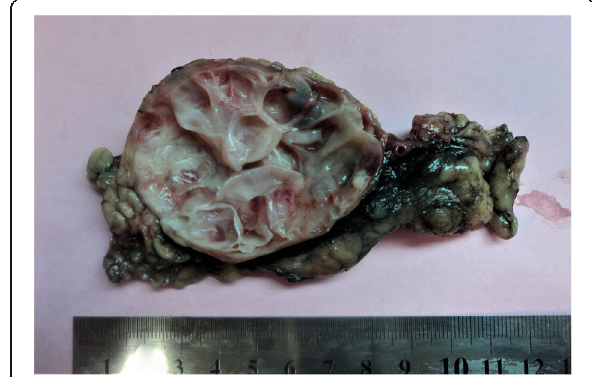
Fig. 2 Gross appearance of mucinous cystic neoplasm. A circumscribed tumor is seen in the tail of pancreas composed of variable sized cysts. The cysts are surrounded by thick fibrotic septae and contained mucoidy material